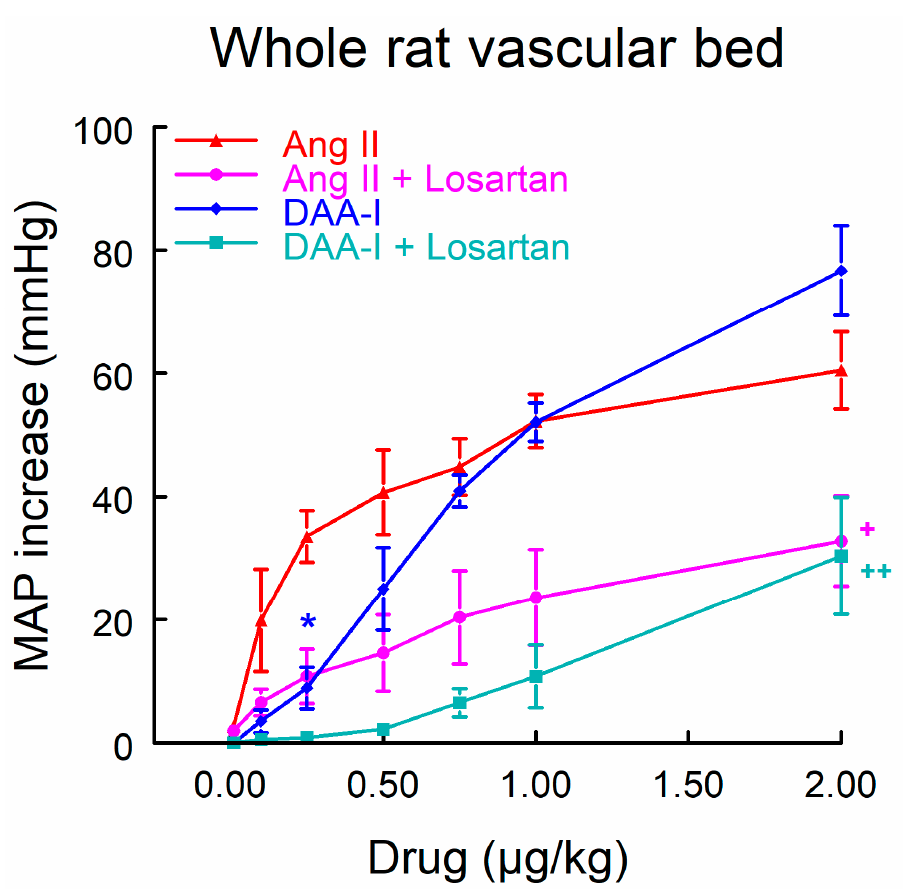
Figure 2. Dose–response curves to DAA-I and to Ang II with or without losartan in whole rat vascular bed. Data were compared using a factorial ANOVA for repeated measures, taking each rat as subject, and group and dose as between-subjects factors. Interactions between factors were analyzed using the Bonferroni method. * p < 0.01 versus the same dose of Ang II. + p < 0.05, ++ p < 0.01 along the curve versus its respective dose–response curve without losartan. Data are means ± standard error of the mean (SEM). n = 6 each group. MAP = mean arterial pressure.